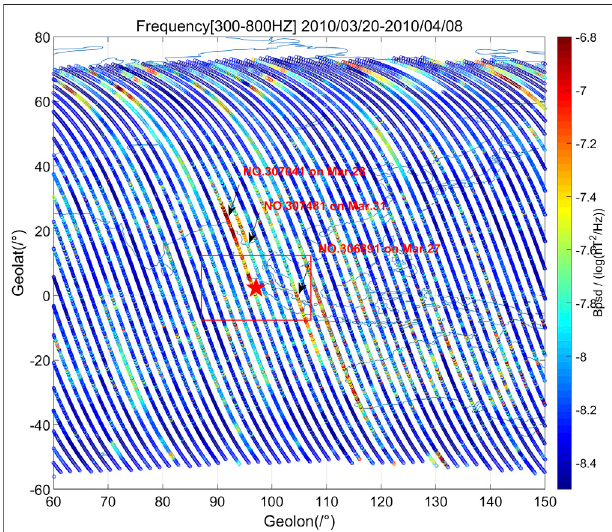
FIGURE1| Thevariationofextremelylowfrequencymagnetic fi eldwave intensity during the 2010 April 6, Mw 7.8 Sumatra earthquake from March 20 to April 8, 2010, represented by power spectral density (PSD) values at frequency range (300 – 800 Hz). The red star denotes the epicenter, the red rectangle indicates the area of study. The horizontal and vertical axis represent the geo-longitude and latitude, respectively; the PSD values are color coded along the orbit